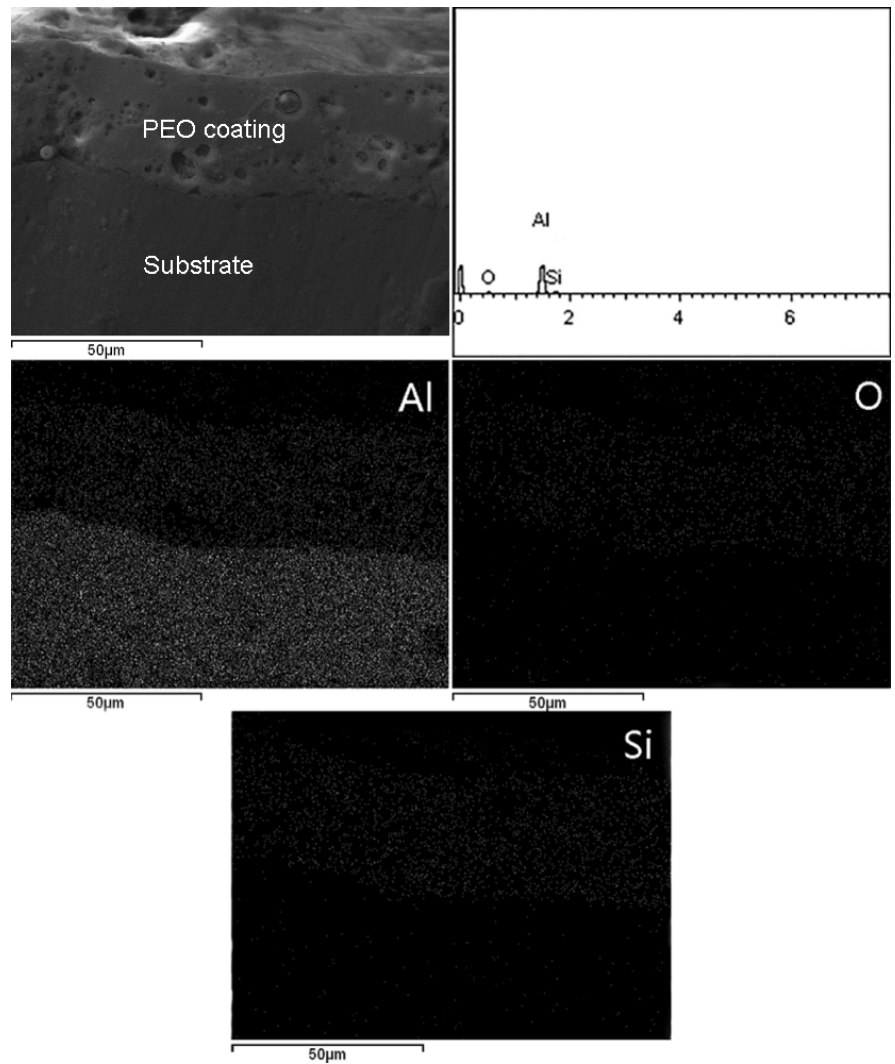
Figure 4. The element distribution of the cross section of the PEO coating.